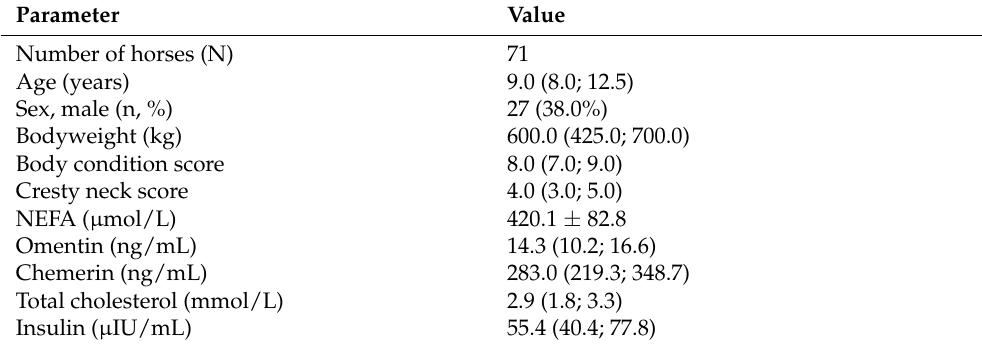
Table 2. Study group characteristics.